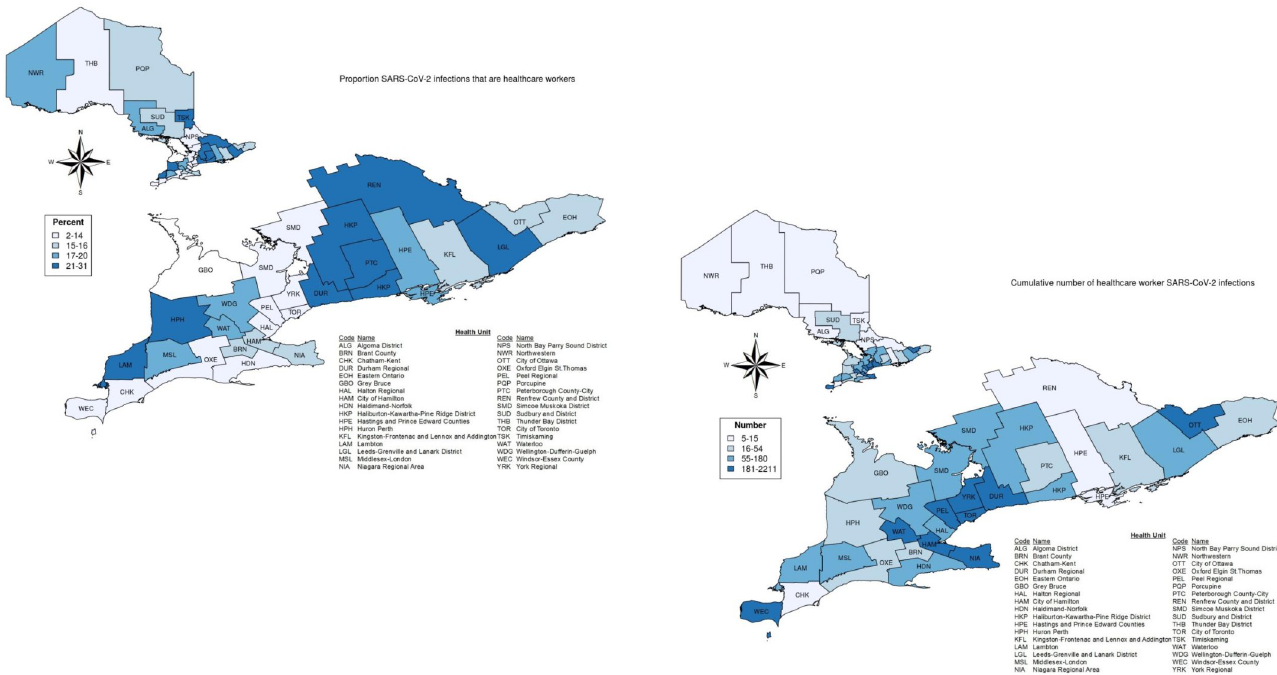
Fig 1. Geographical variability by Ontario public health unit until 30 September 2020. Left map shows the percent of total SARS-CoV-2 infections in each region that are healthcare workers. Right map shows the cumulative number of healthcare worker SARS-CoV-2 infections.